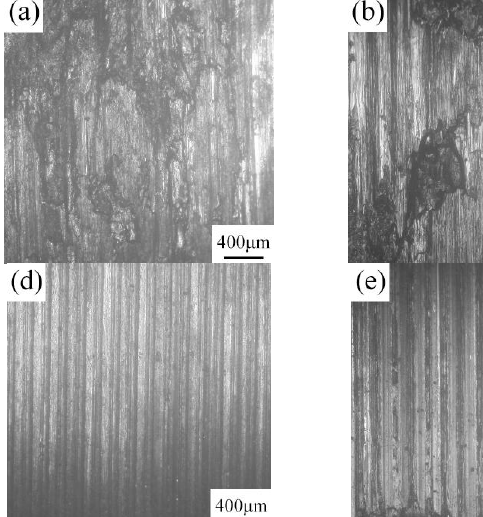
Figure 7. Two-dimensional friction surface morphology of tin bronze ( a – c ) and tin bronze-based ISSLB materials ( d – f ), ( a , d ) 100 N, ( b , e ) 300 N, ( c , f ) 500 N.